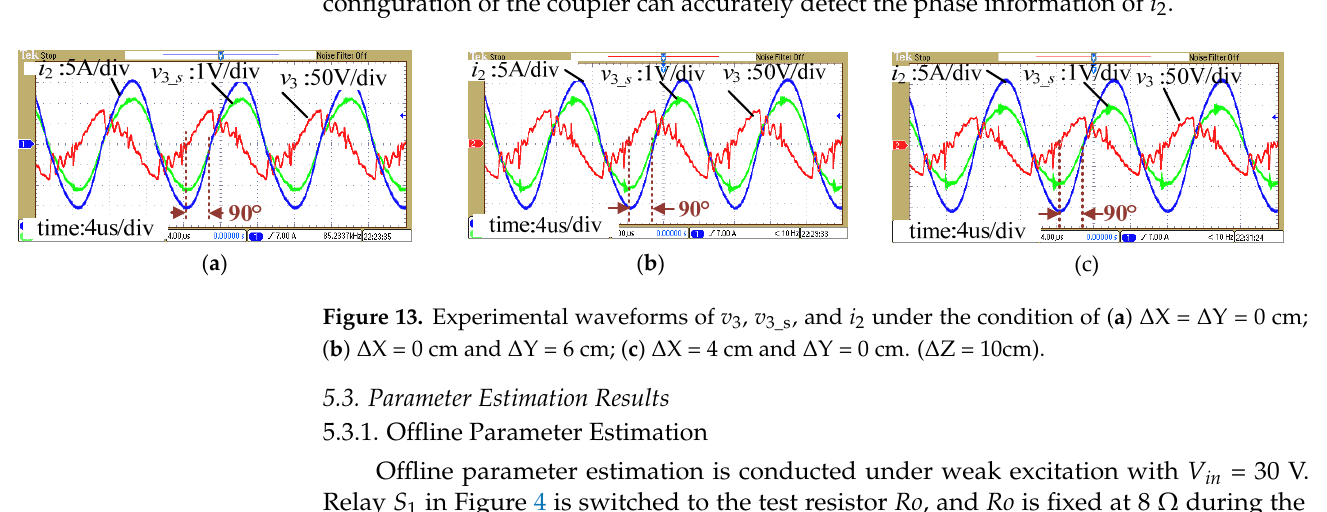
Figure 12. Measured mutual inductances of M 12 , M 23 , and M 13 under ( a ) misaligned conditions with ∆ Z = 10 cm and ( b ) different clearance conditions with ∆ X = ∆ Y = 0 cm.